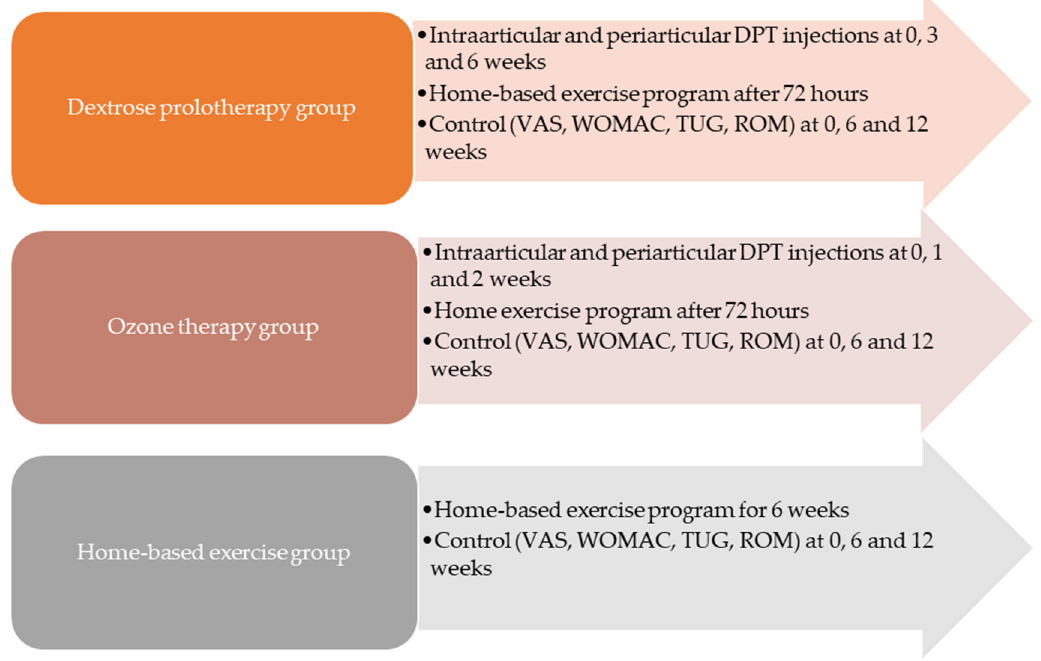
Figure 1. Study Figure 1. Study design .